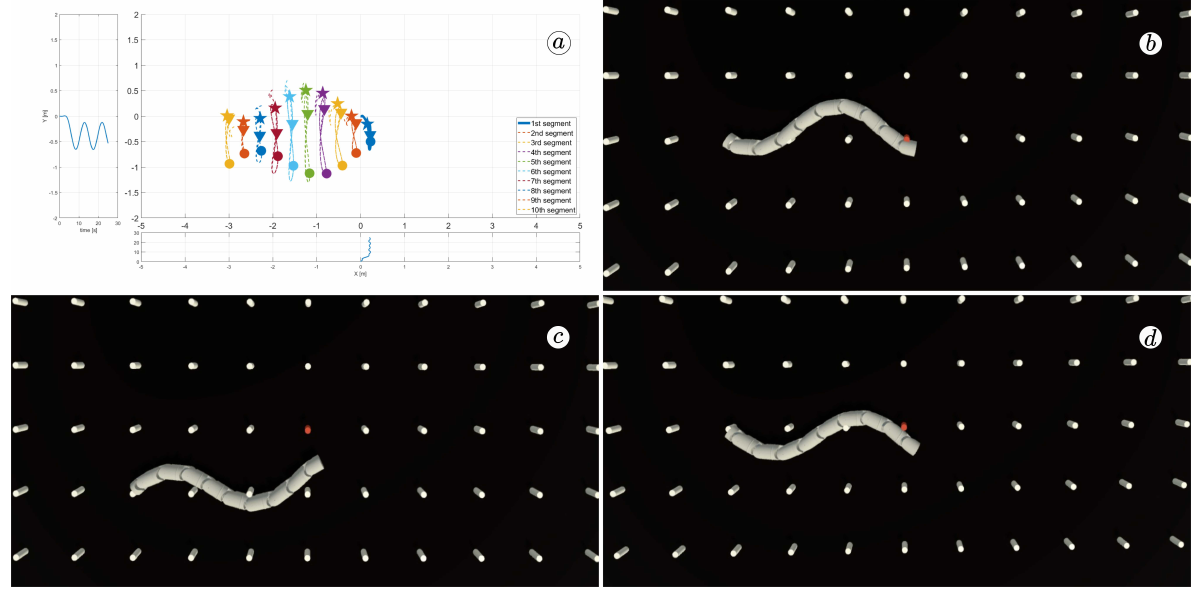
Figure 10. Trajectories of robot segments for c t = 10 and c n = 10 ( a ) and robot configurations for t = 5 ( s ) ( b ), t = 10 ( s ) ( c ), and t = 24 ( s ) ( d